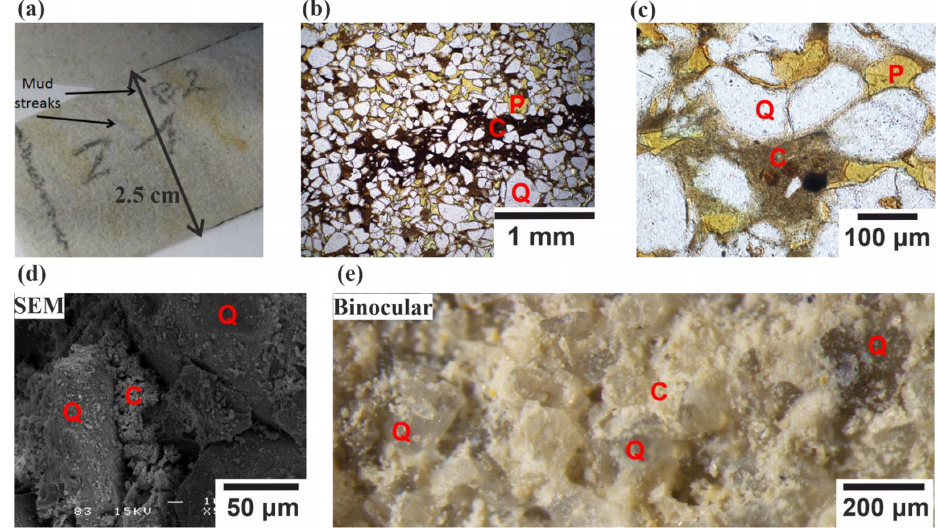
Figure 4. Representative images of sandstone S2. (a) Dark stains in the rock are mud streaks; yellowish zones are due to increased FeOx cement. (b) The dark laminae are richer in clays and FeOx. P refers to open pores, Q to quartz, and C to clay. (c) Clay and silt accumulated as meniscus and as a clay matrix. (d) Pore clogged by clay and FeOx. (e) Rock texture. The clay matrix is white, and quartz grains are pale